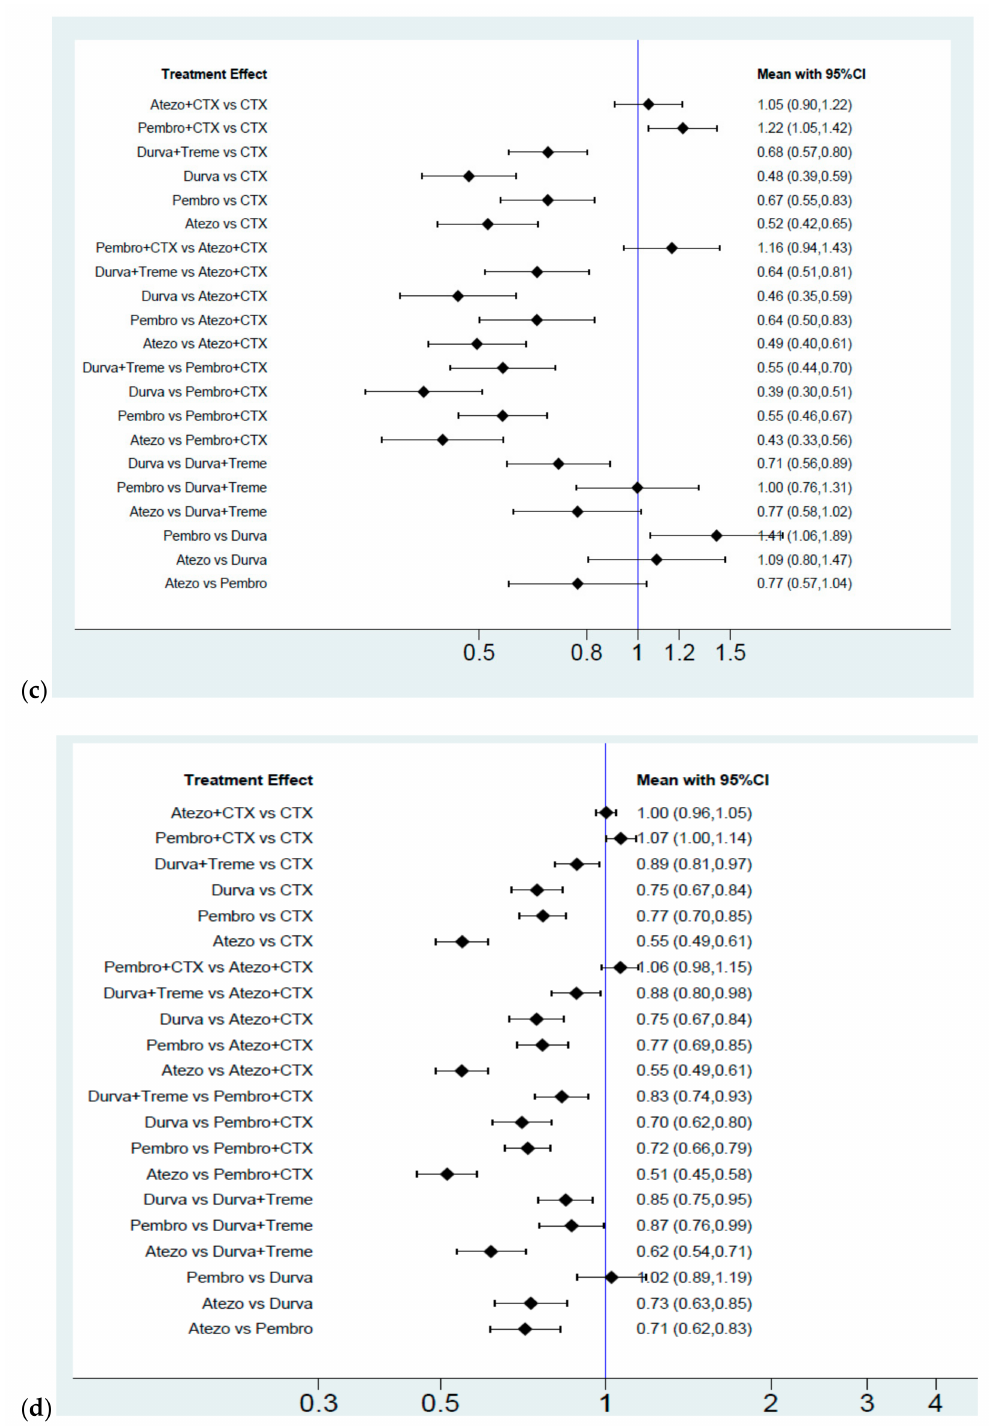
Figure 3. Summary of effect size for pairwise comparison. ( a ) Hazard ratio for overall survival, ( b ) hazard ratio for progression free survival, ( c ) response ratio for overall response rate, ( d ) risk ratio for grade 3–5